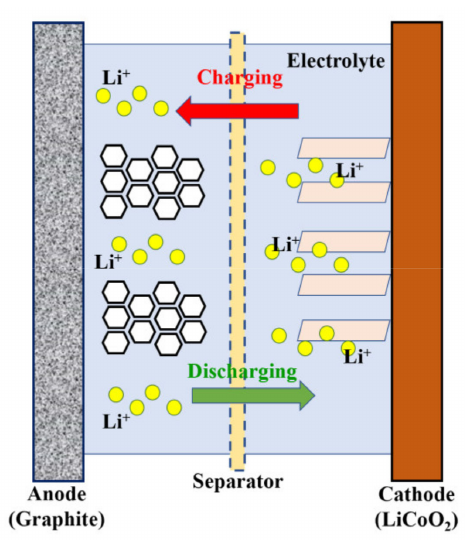
Figure 3. Schematic of the structure and working mechanism of Li-ion